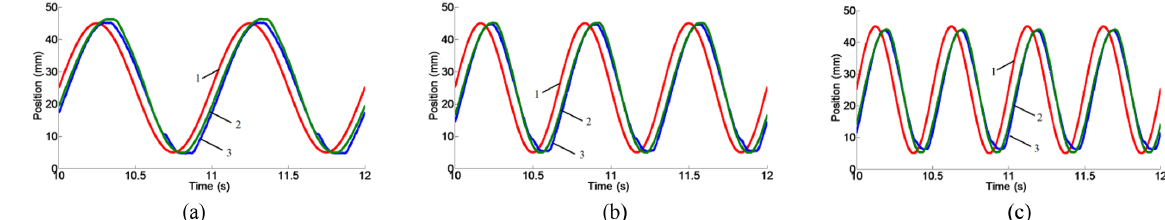
Figure 15. Position response curves at different frequencies. Response curves of (a) 1.0Hz, (b) 1.5Hz and (c) 2.0Hz.